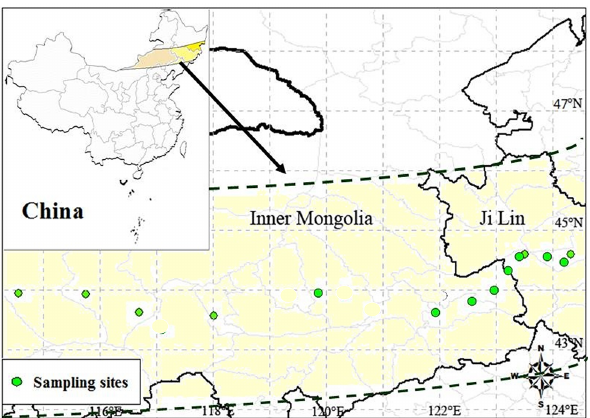
Figure 1. Study sites (1–14; see Table 1) along the 1000km longitu- dinal transect in native Leymus chinensis grasslands of northeastern